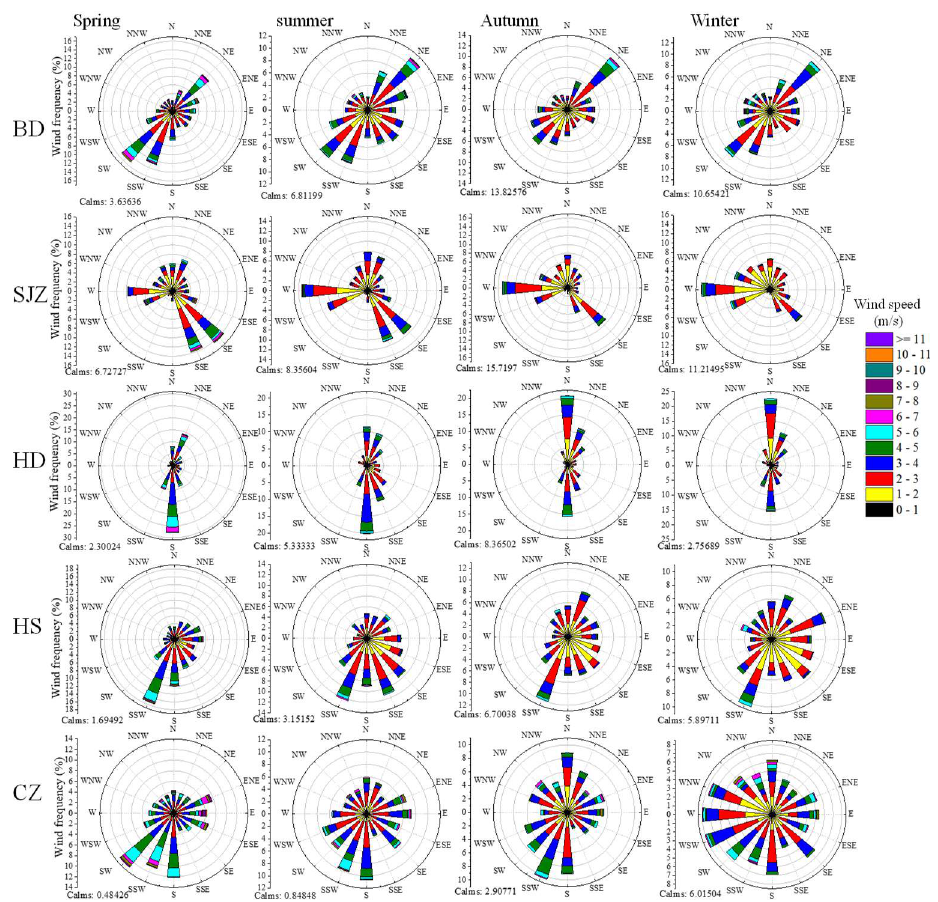
Figure 5. Wind rose plots for the four seasons in the five cities during 2013–2015. Calms represents wind speed <1 ms −1